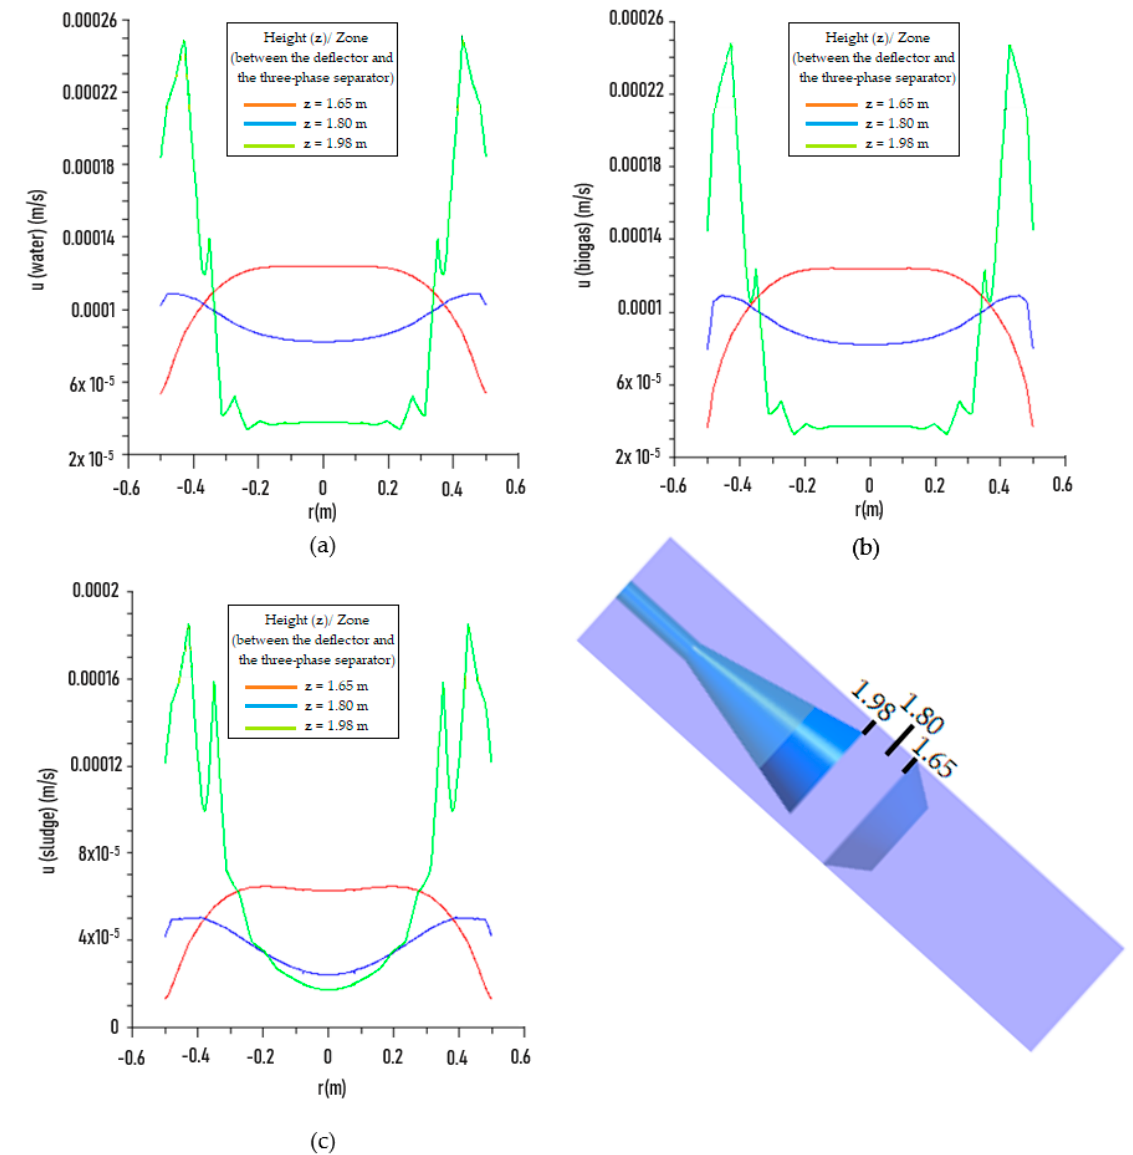
Figure 15. Distribution of the resulting velocity according to the radial position for different axial positions, z, on the region between the deflector and three-phase separator (downward inclination of the deflector): ( a ) water, ( b ) biogas, and ( c ) sludge.